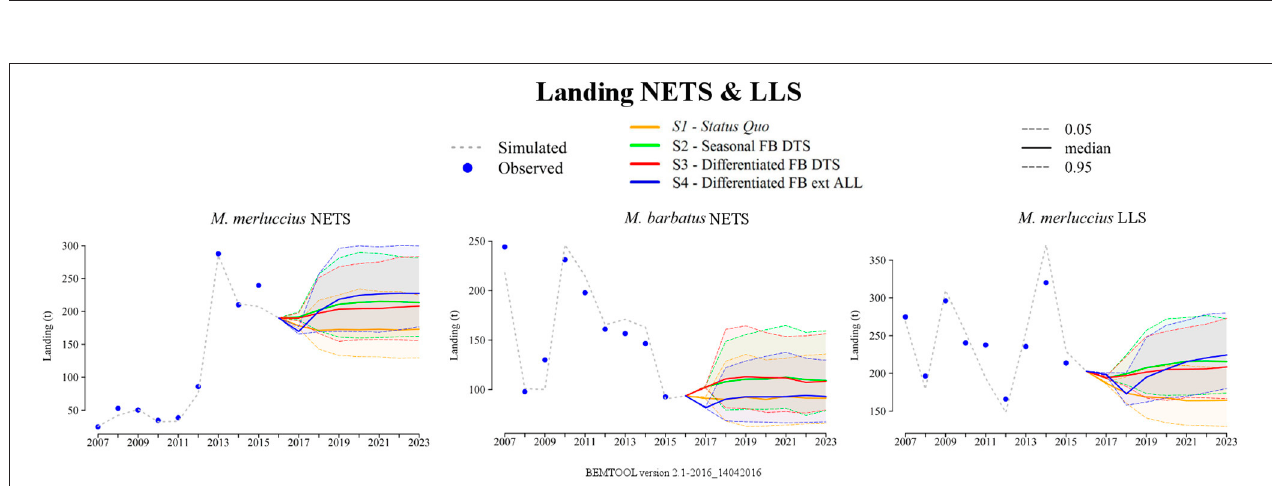
FIGURE 7 | Comparison among the scenarios of landings (nets and longlines) of European hake and red mullet in the hindcasting (2007–2016) and forecasting (2017–2023) timelines. Dotted line, Hindcasting from the bioeconomic modeling tool (BEMTOOL); Blues points, observed landing (DCF data).